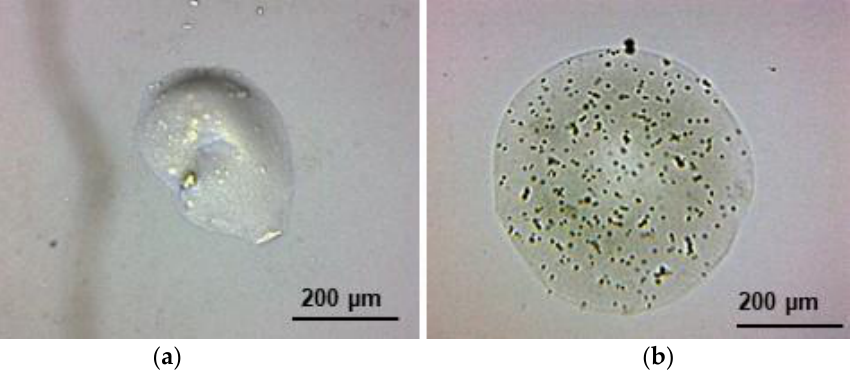
Figure 3. SBWP/AX ( a ) and SBWP/AX+ S. boulardii ( b ) microbeads images. Optical microscopy observation at 10× magnification.